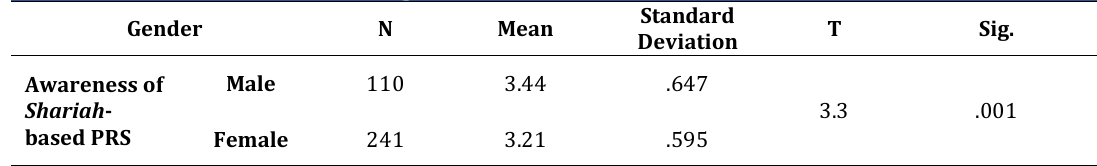
Standard T Sig. Deviation